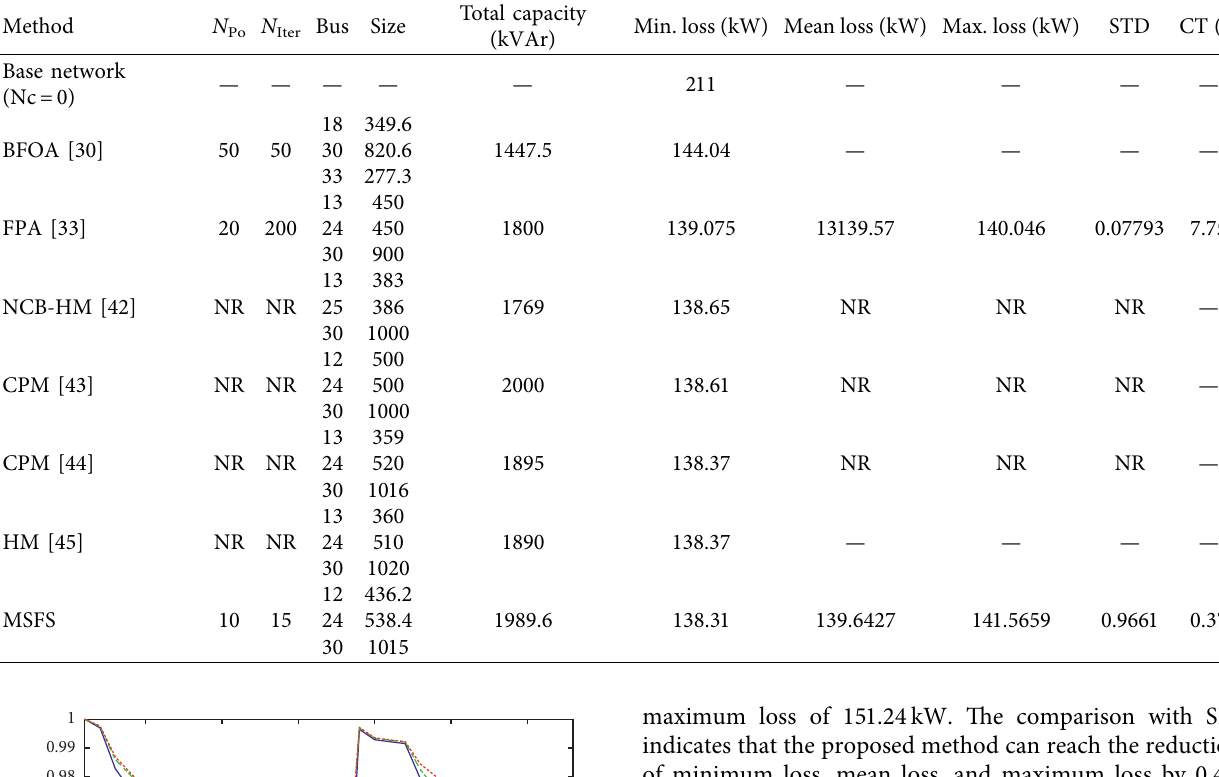
Table 3: Comparison with other methods for case 2 of the 33-bus system.